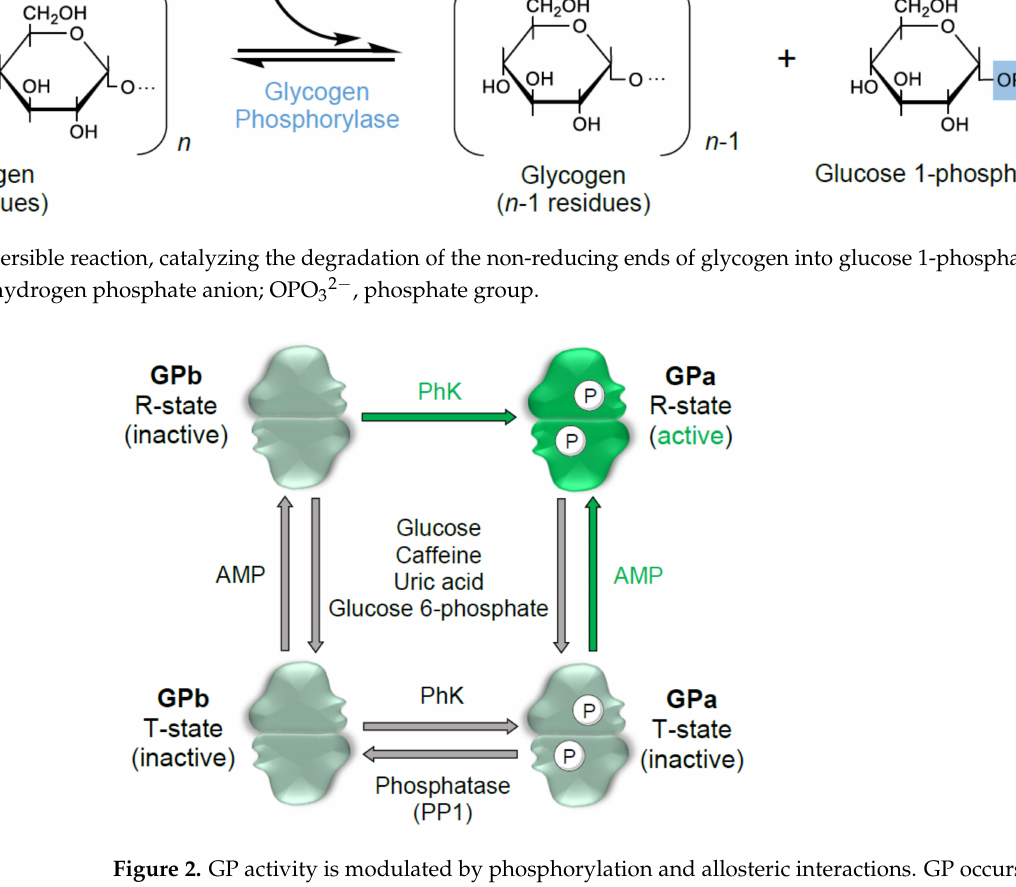
Figure 2. GP activity is modulated by phosphorylation and allosteric interactions. GP occurs as two interconvertible forms, the phosphorylated GPa, and the dephosphorylated GPb. The phosphorylase kinase (PhK) enzyme yields GPa, while dephosphorylation occurs by protein phosphatase 1